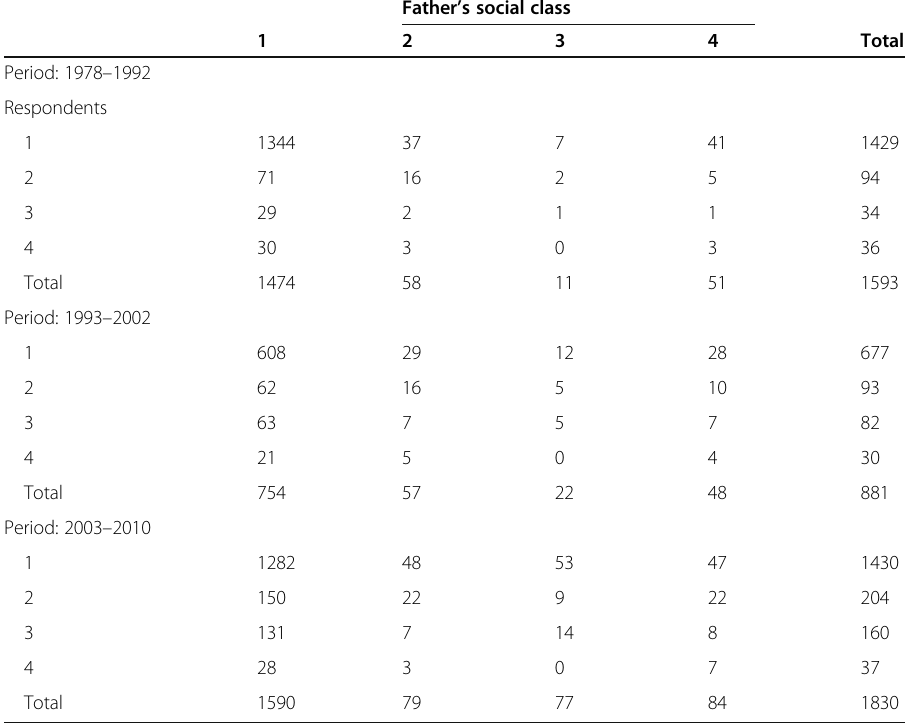
Table 4 Cross-classification of origin and destination (current